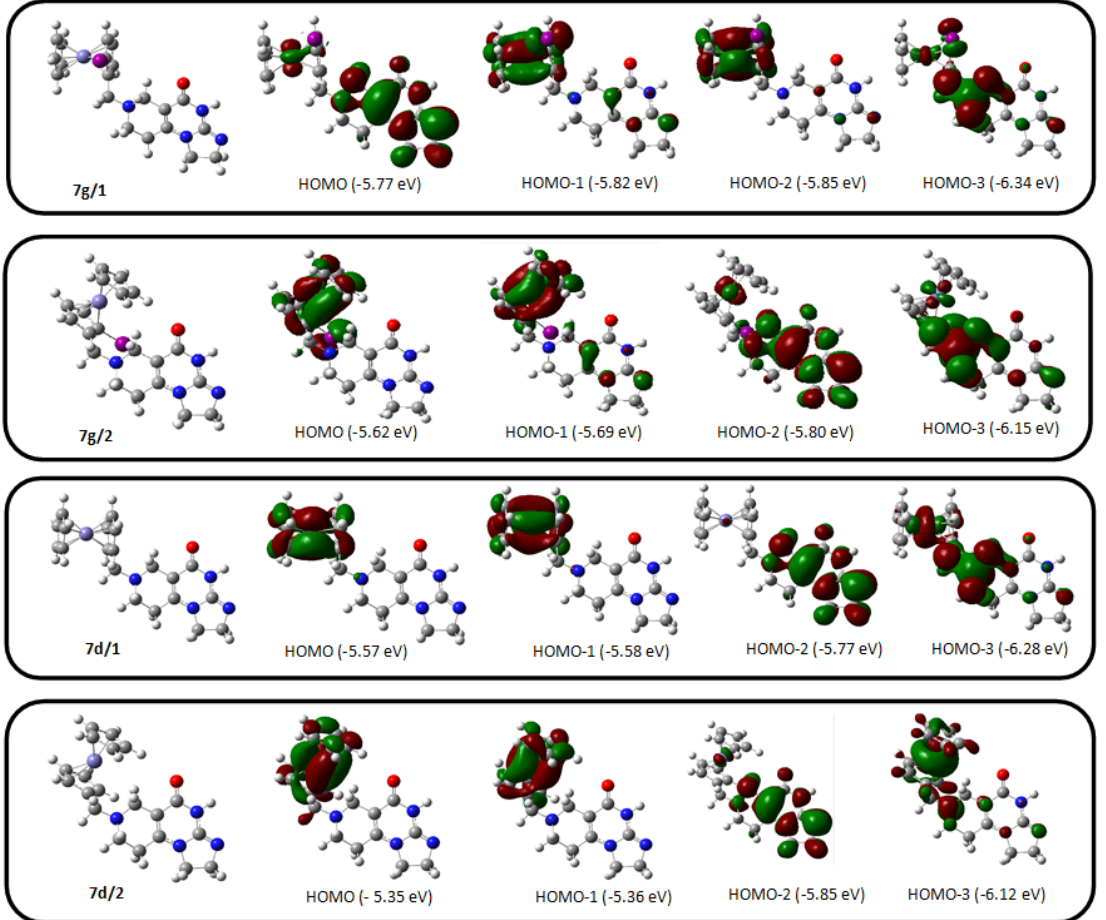
Figure 2. Optimised structures and four occupied MO’s of the stable rotamers of simplified N7-(2-iodoferrocenyl)/ferrocenylmethyl-substituted impiridone models 7g and 7d . HOMO: Highest Occupied Molecular Orbital.